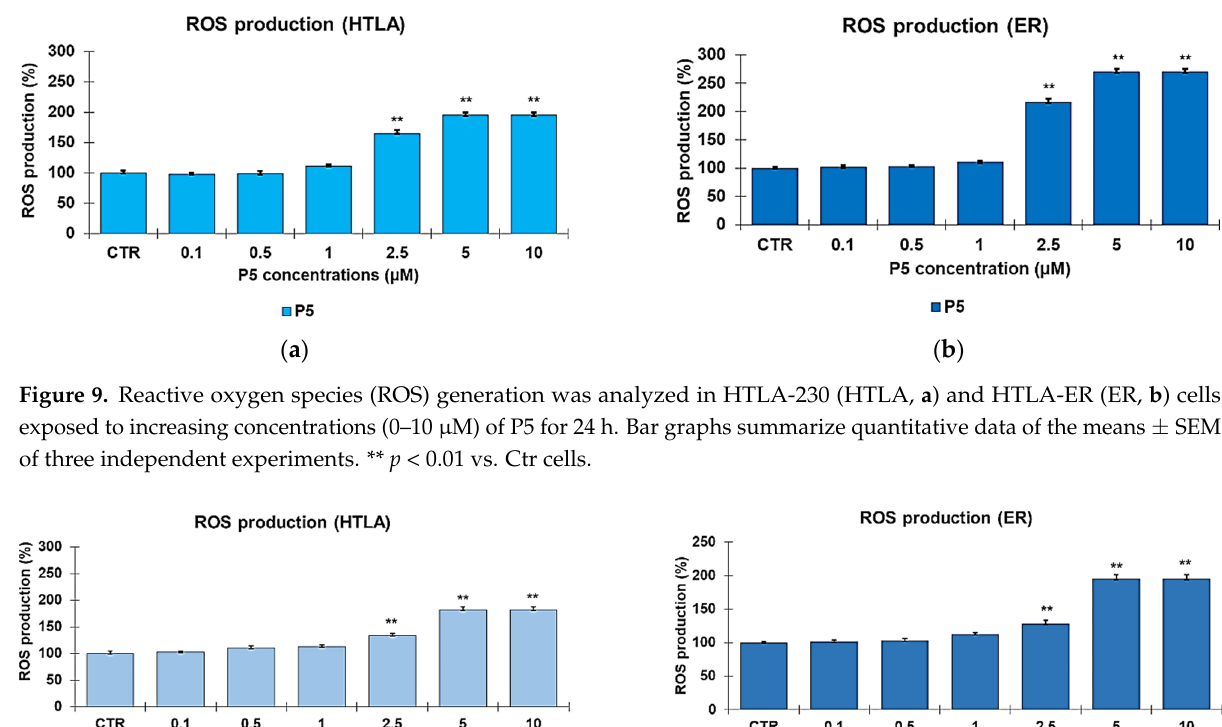
Figure 10. ROS generation was analyzed in HTLA ( a ) and ER ( b ) NB cells exposed to increasing concentrations (0 – 10 µM)